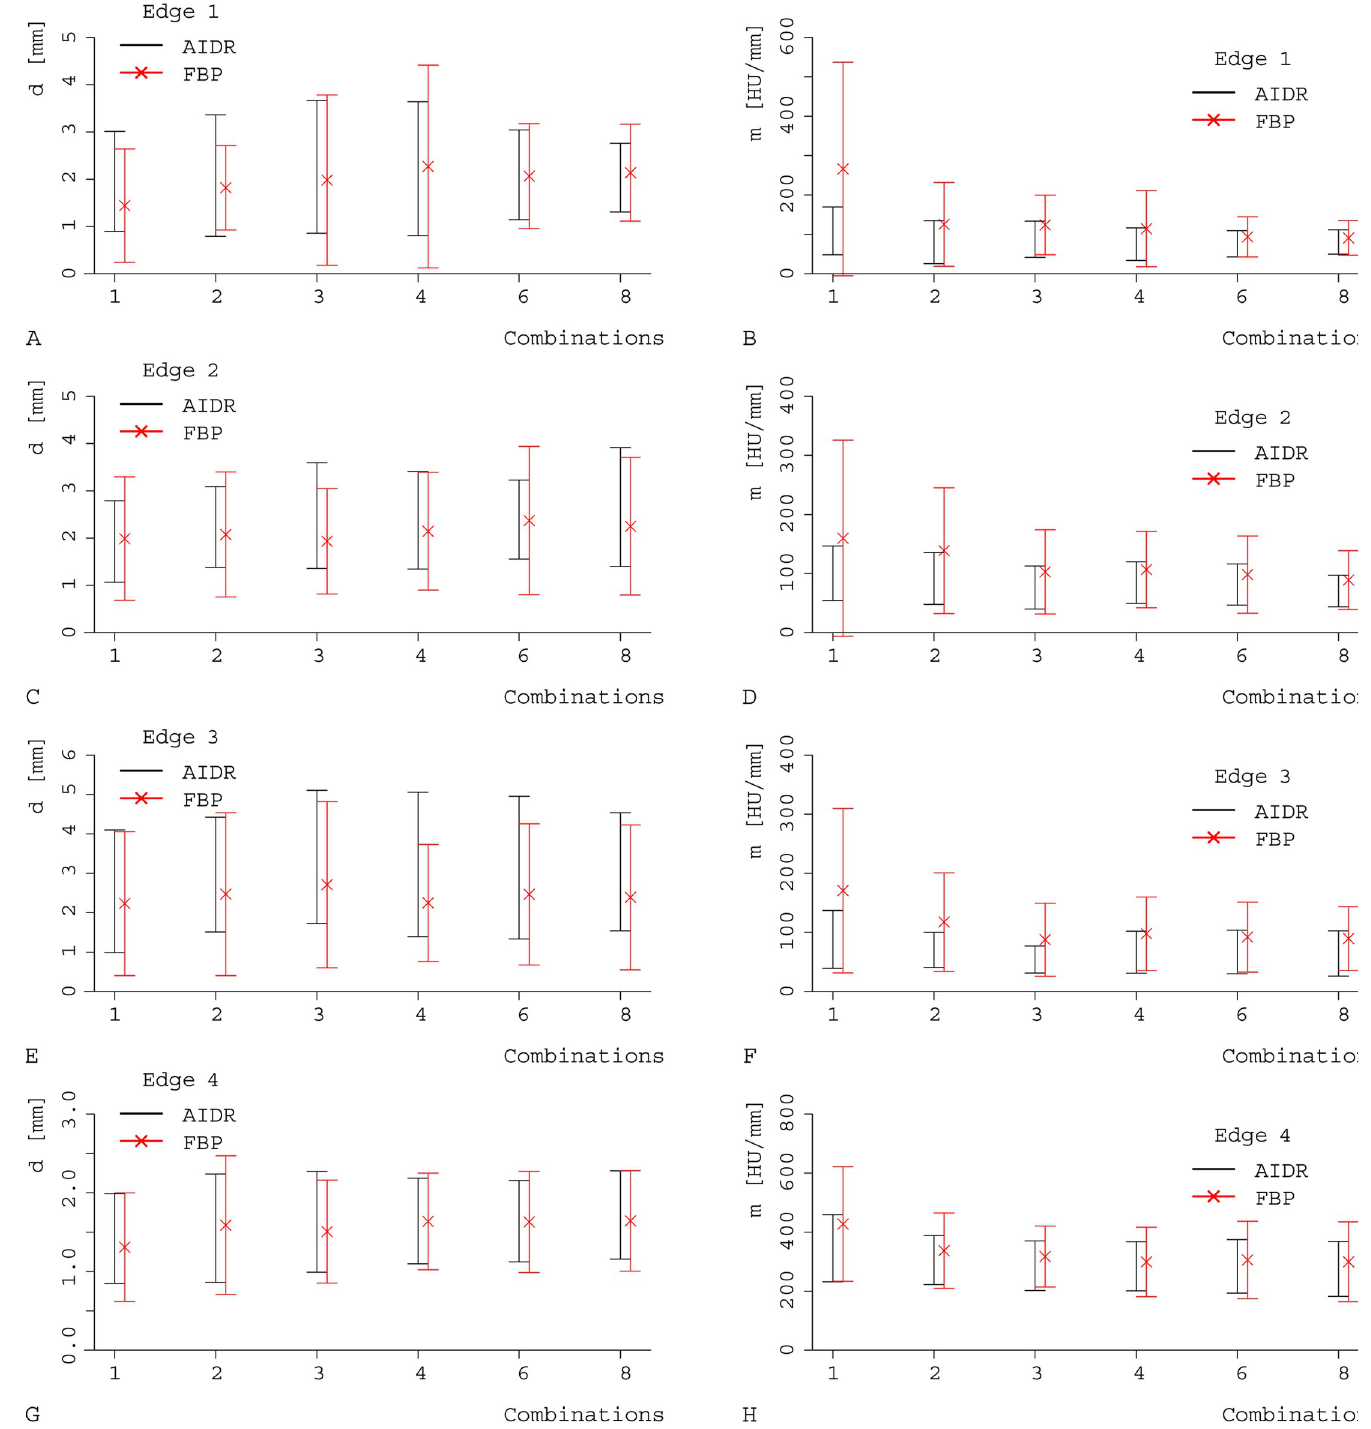
Fig 4. Comparison of the contour sharpness parameters. Values are given as mean ± SD between AIDR 3D (black) and FBP (red) and for the different levels of temporal averaging (1–8; x axis). We used two different quantitative parameters: the distance between 25%-75% of the maximal grey value (d; A, C, E, G) and the slope (m; B, D, F, H) at four different edges: edge 1 (A, B), edge 2 (C, D), edge 3 (E, F), and edge 4 (G, H). At all 4 edges, higher levels of temporal averaging and AIDR 3D showed poorer contour sharpness parameters (higher values for d, lower values for m) compared with FBP.